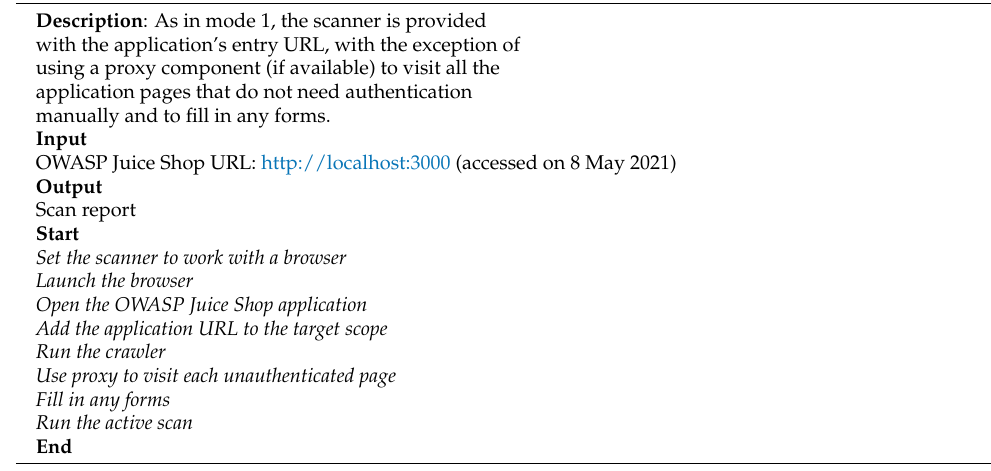
Algorithm 2 Mode 2: Unauthenticated scan with proxy